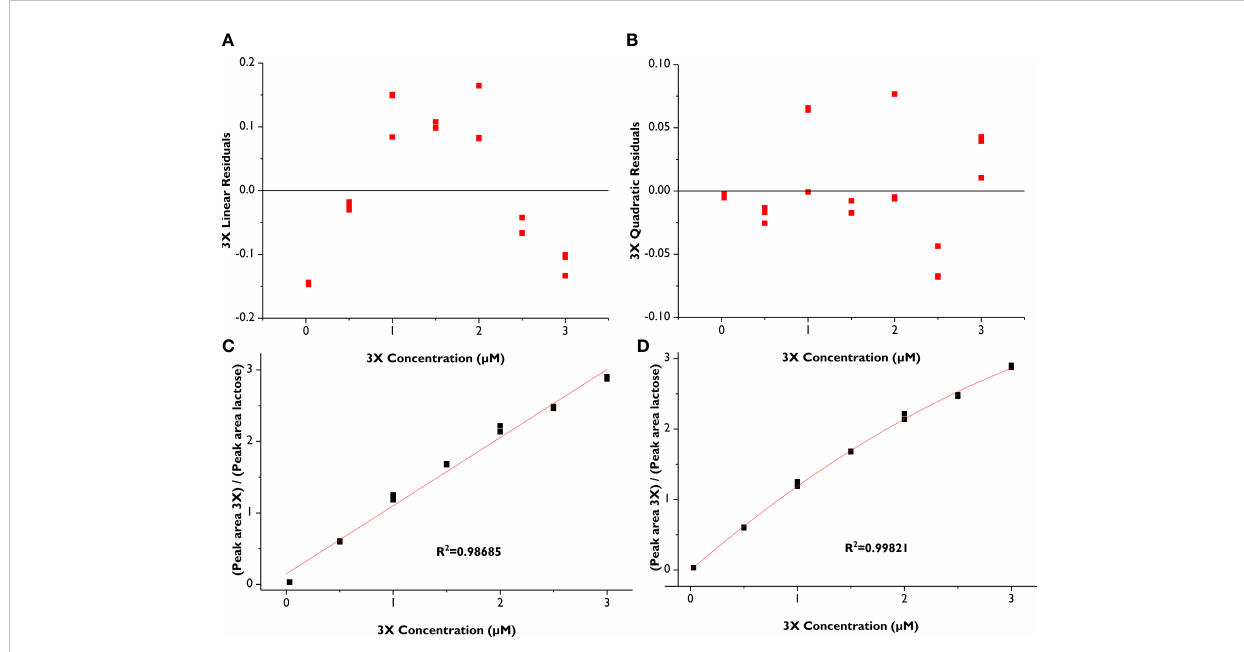
FIGURE 3 Comparison of linear vs. quadratic fi t for xylotriose (3X) calibration curves (in triplicate). (A) Residual plot from linear fi t; (B) Residual plot from quadratic fi t, (C) Linear calibration curve; (D) Quadratic calibration